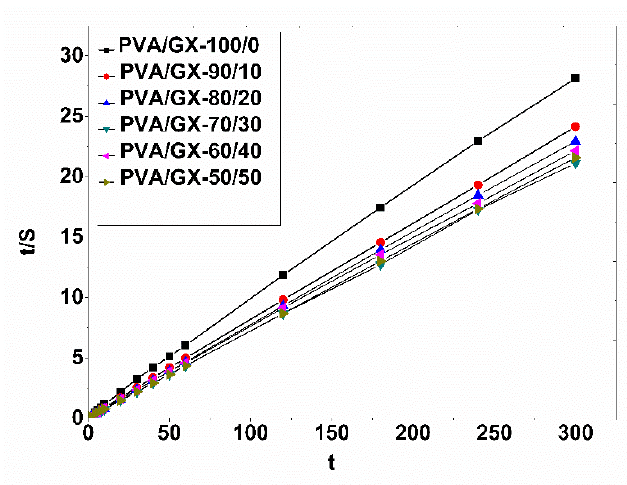
Figure 7. Comparison of t/S and t relationships of PVA/GX hydrogels.